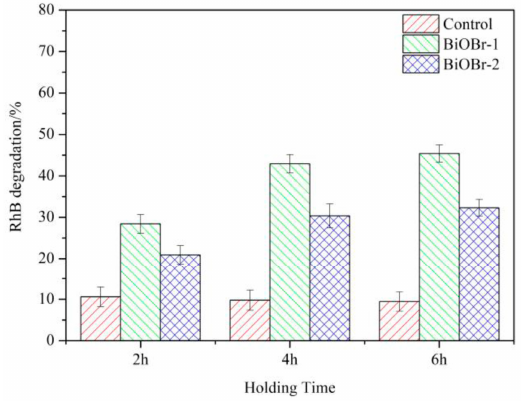
Figure 1. RhB degradation rate of different samples as a function of autoclaved curing time.